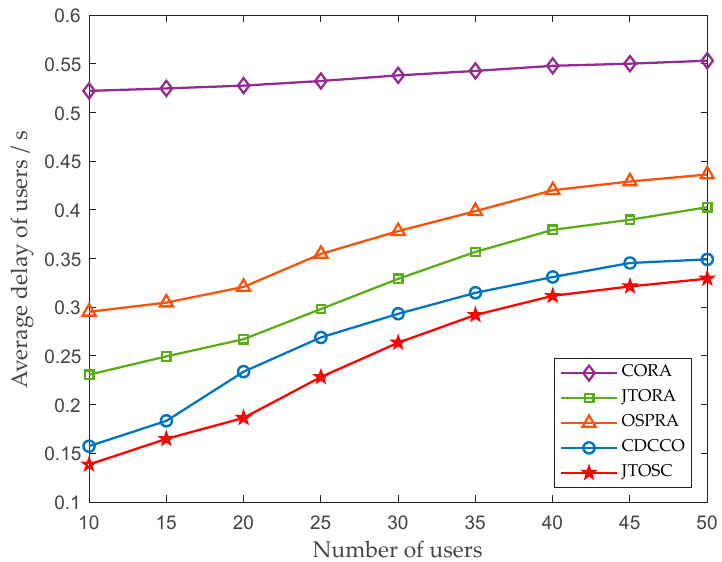
Figure 3. The impact of the number of users on the average delay of users. In Figure 4, the impact of the computing capabilities of MEC servers on the maximum delay of all users is illustrated. The improvement of the computing capabilities does not have any influence on the CORA strategy, since its edge servers do not cache computing services and cannot participate in computing any user tasks. In the remaining four strate- gies, with the computing capabilities of edge servers increasing, the computing resources allocated to user increase, then the computing delay decrease. However, due to the limita- tion of storage resources of edge servers, they are unable to cache more services to perform more tasks, so the downward trend gradually stabilizes. In addition, it can be visualized from Figure 4 that the performance difference between MECs’ non-collaboration (OSPRA and JTORA) and collaboration (CDCCO and JTOSC) strategies gradually decreases. This is because that the number of user tasks, which can be processed by the associated MEC itself, increases with the greater computing capabilities.